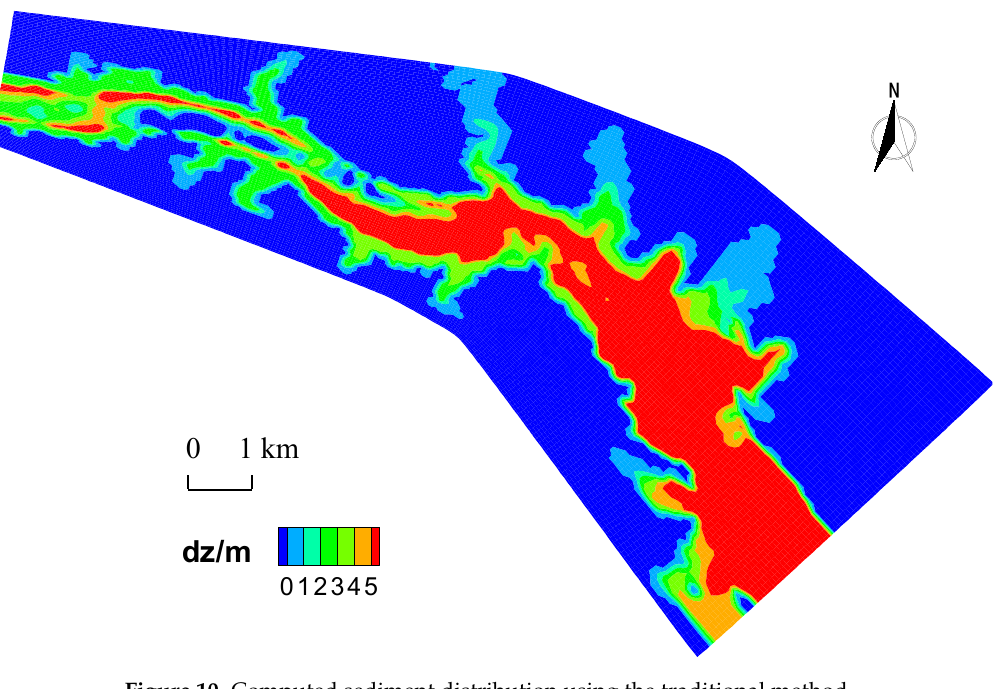
Figure 10. Computed sediment distribution using the traditional method.